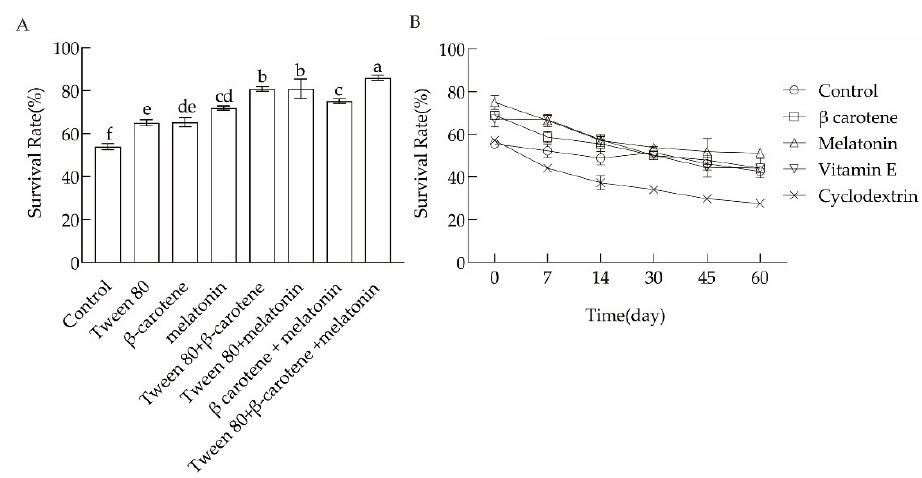
Figure 3. Effects of exogenous substances on the lyophilization survival rate ( A ) and storage of L. plantarum ( B ). Different letters indicate significant differences ( p < 0.05).